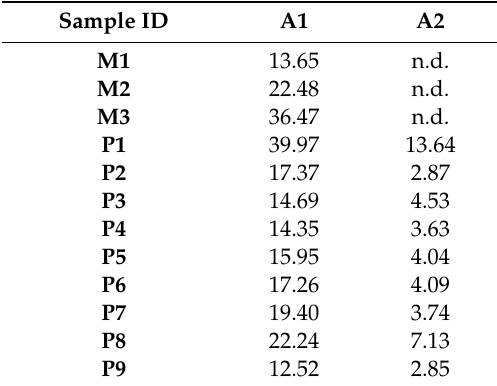
Table 2. Levels of two specific ceramides in three almond and nine pistachio